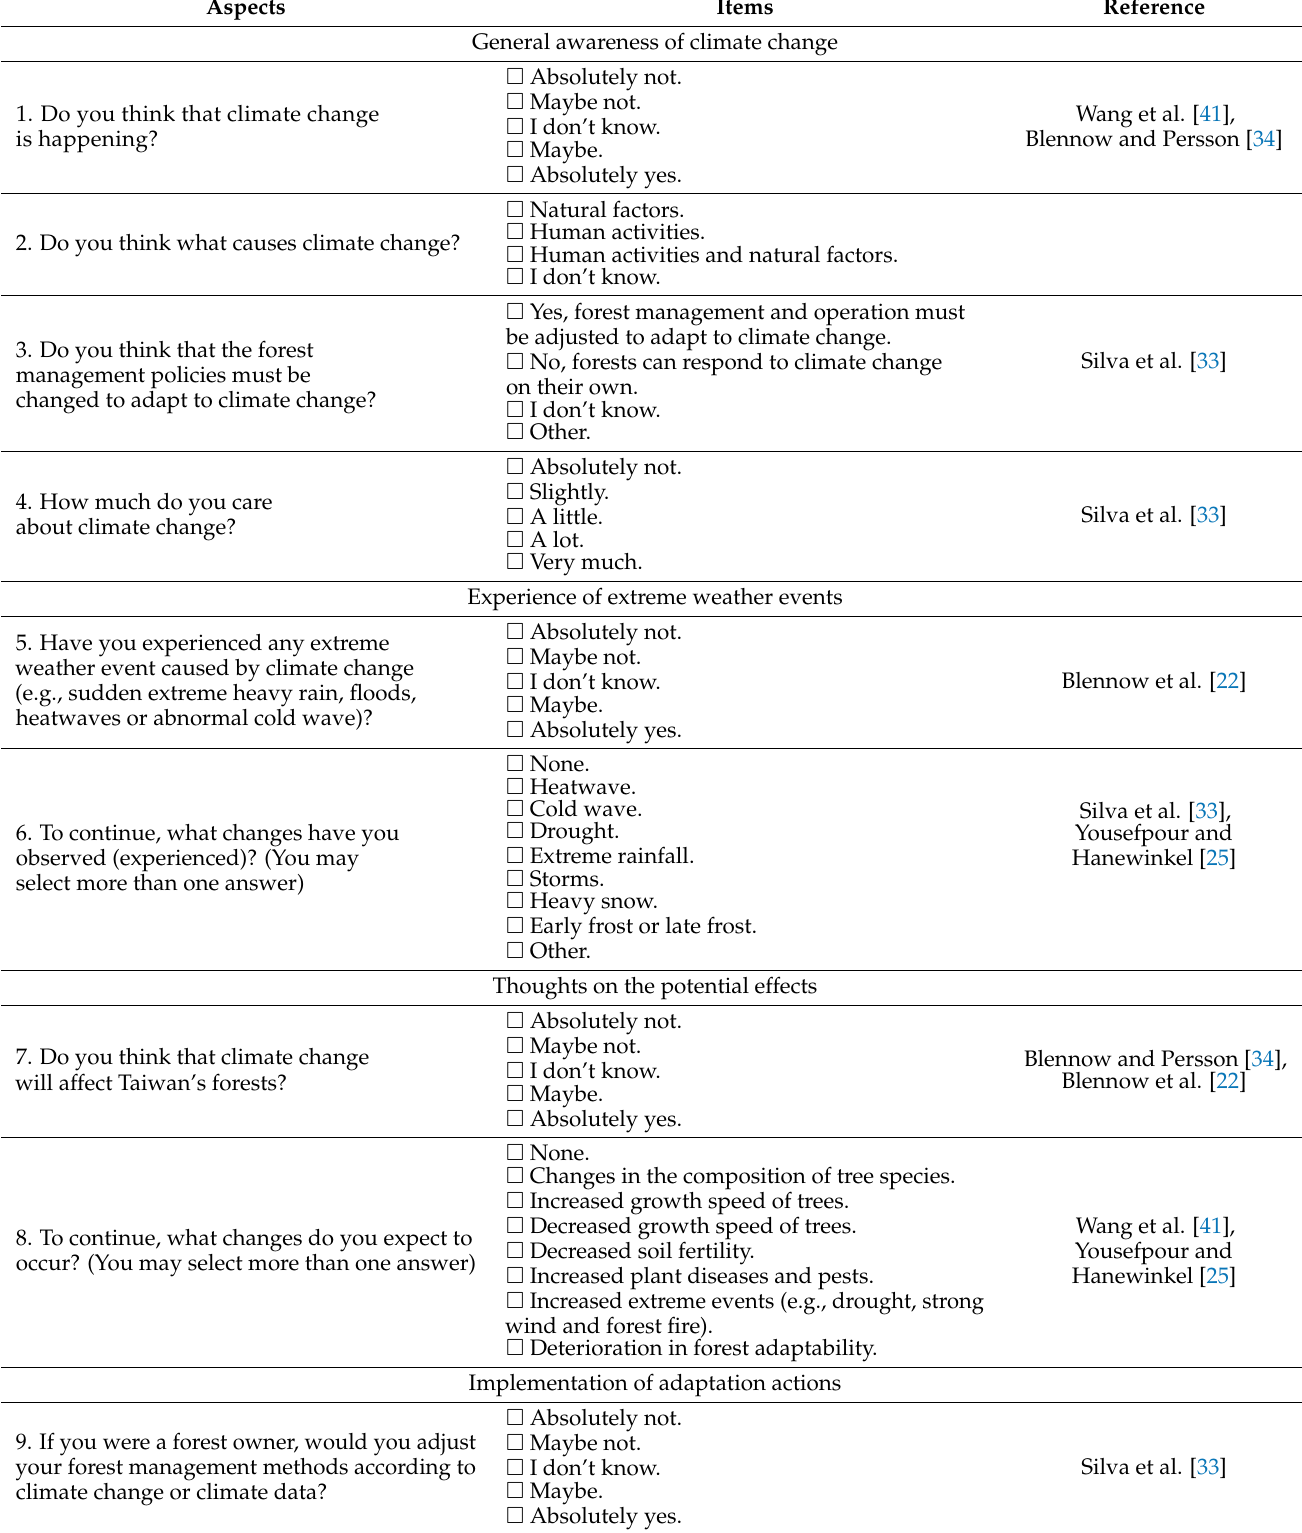
Table 1. Questionnaire